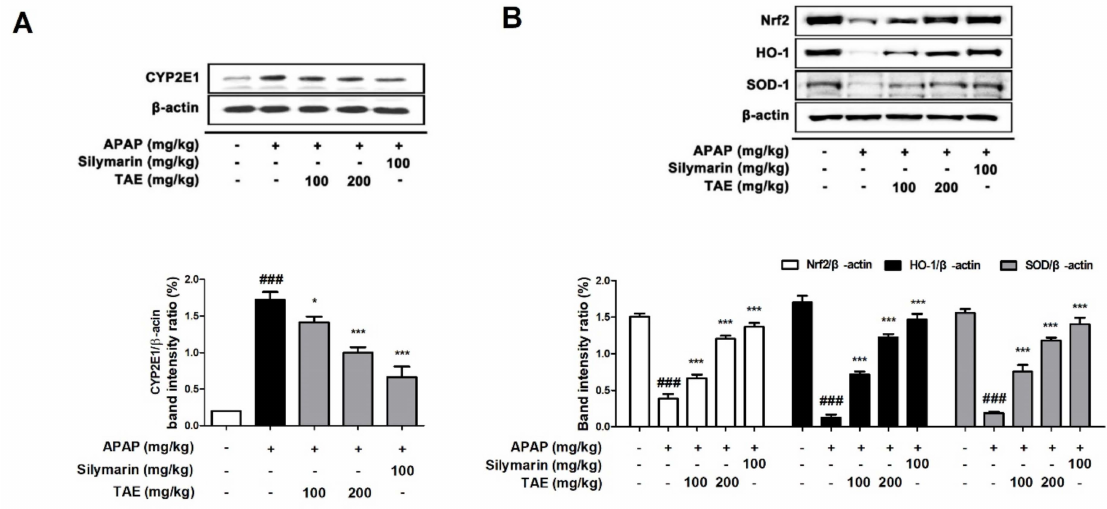
Figure 5. Effects of ethanolic Triticum aestivum sprout extract on CYP2E1 and Nrf2 pathway proteins in mice with N -acetyl- para-aminophenol (APAP)-induced hepatotoxicity. ( A ) Quantitative analysis of CYP2E1 protein expression. ( B ) Quantitative expression analysis of Nrf2 regulatory target proteins: Nrf2// β -actin, HO-1/ β -actin, and SOD-1/ β -actin. All data are shown as mean ± SD. ### p < 0.001 versus Normal group; * p < 0.05, and *** p < 0.001 versus APAP group. APAP, N -acetyl-para-aminophenol (acetaminophen); CYP2E1, Cytochrome P4502E1; HO-1, heme oxygenase-1; Nrf2, Nuclear factor erythroid 2 -related factor 2; SOD, superoxide dismutase; TAE, Triticum aestivum sprouts extract.